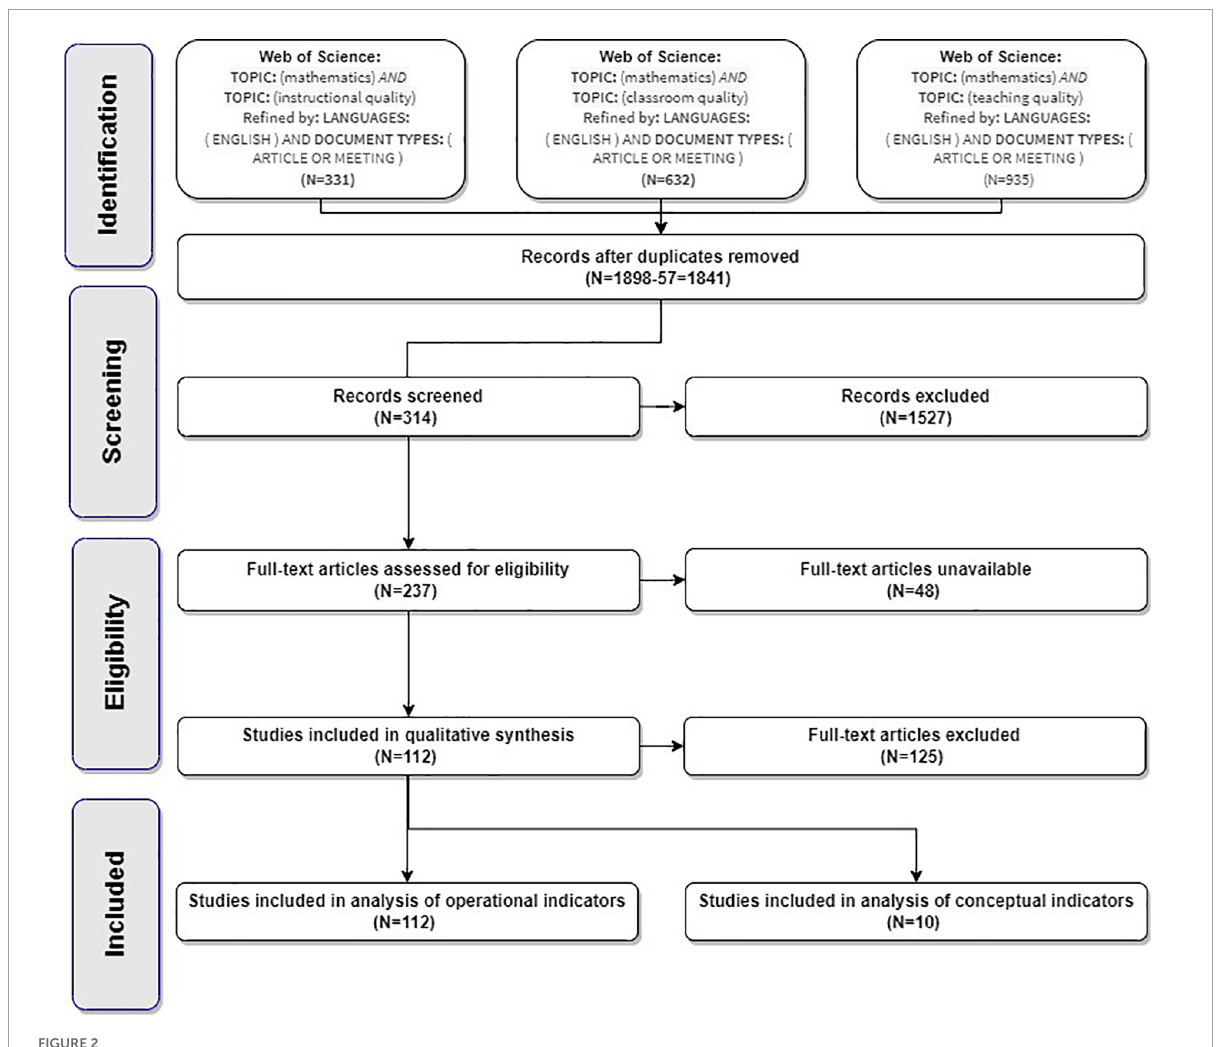
FIGURE2 PRISMA flow